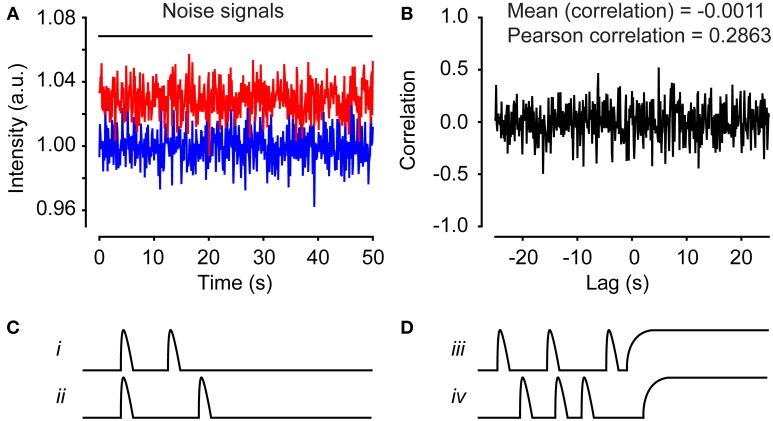
Time series can produce false correlations. (A) Two separate time series consisting of pseudorandom numbers normally distributed. (B) The cross-correlation calculation for the time series in (A). The mean correlation is −0.0011 and the Pearson correlation is 0.2863. Illustration of false-positive cell pairs with high correlations due to small numbers of peaks (C) or sustained plateau increases (D).